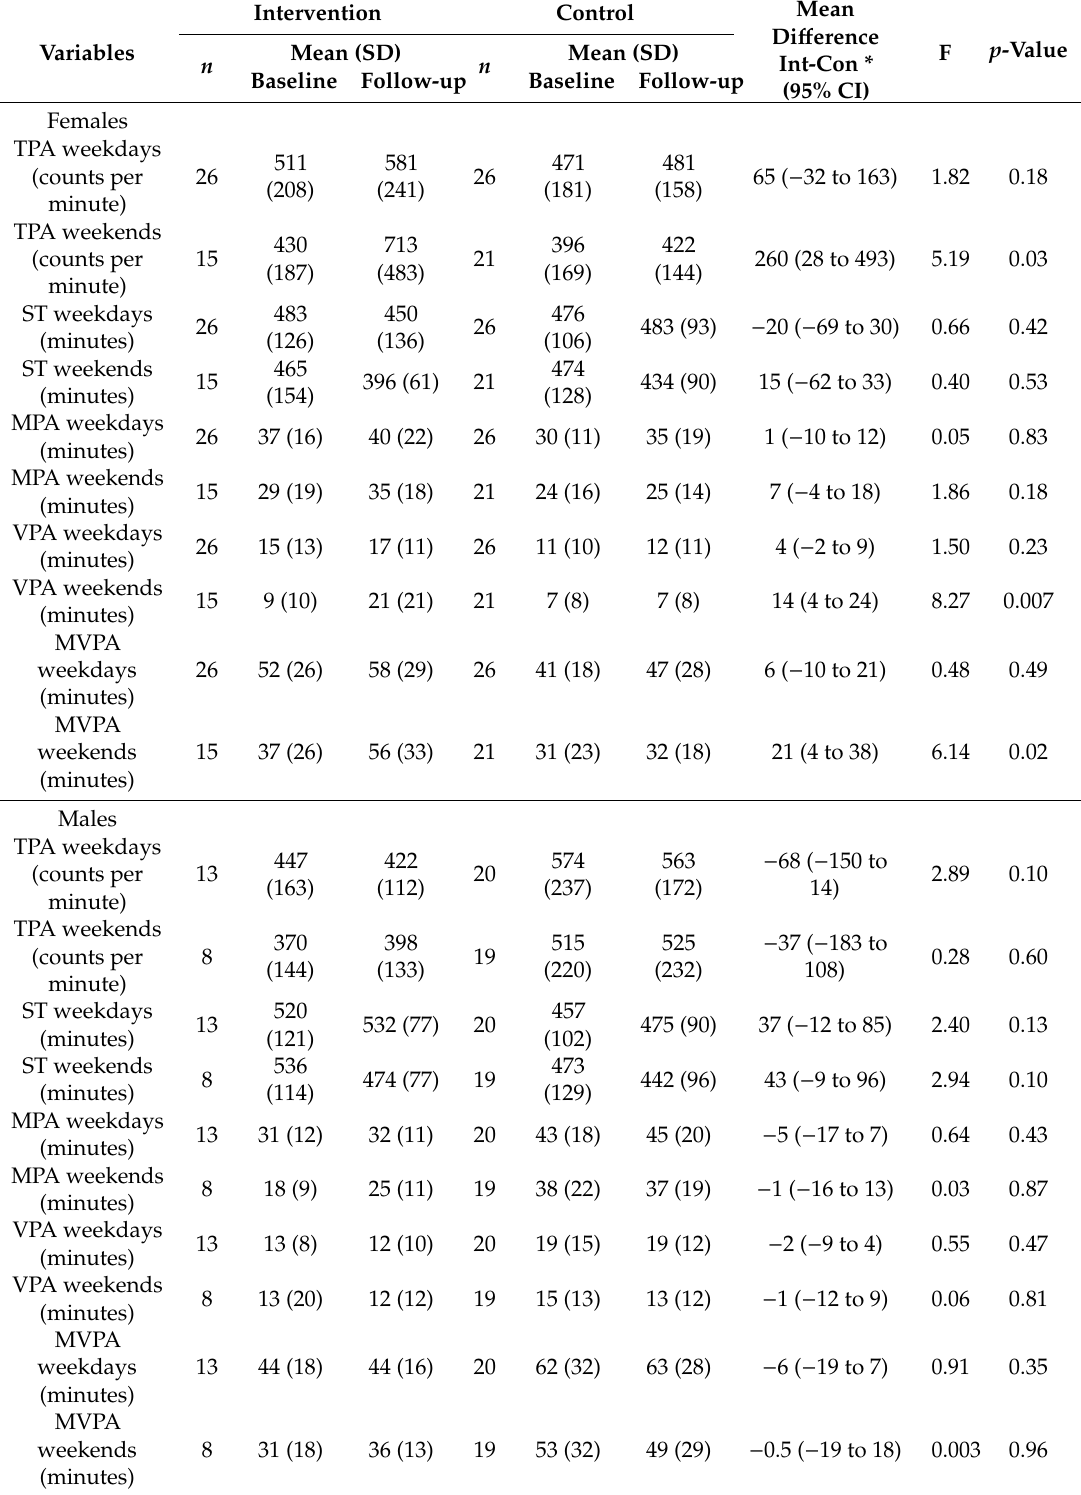
Table 3. Di ff erences between intervention and control groups in physical activity and sedentary time categorized by